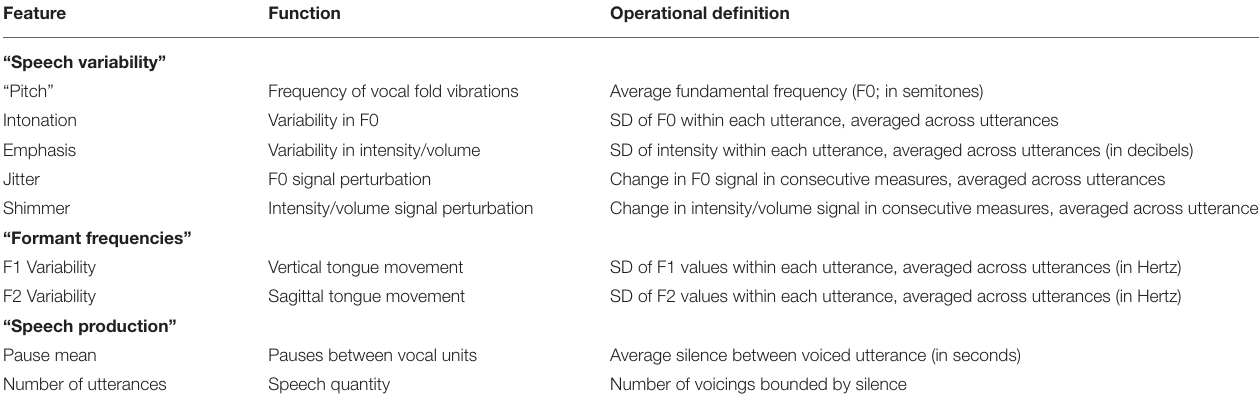
TABLE 2 | Vocal properties and features examined in this